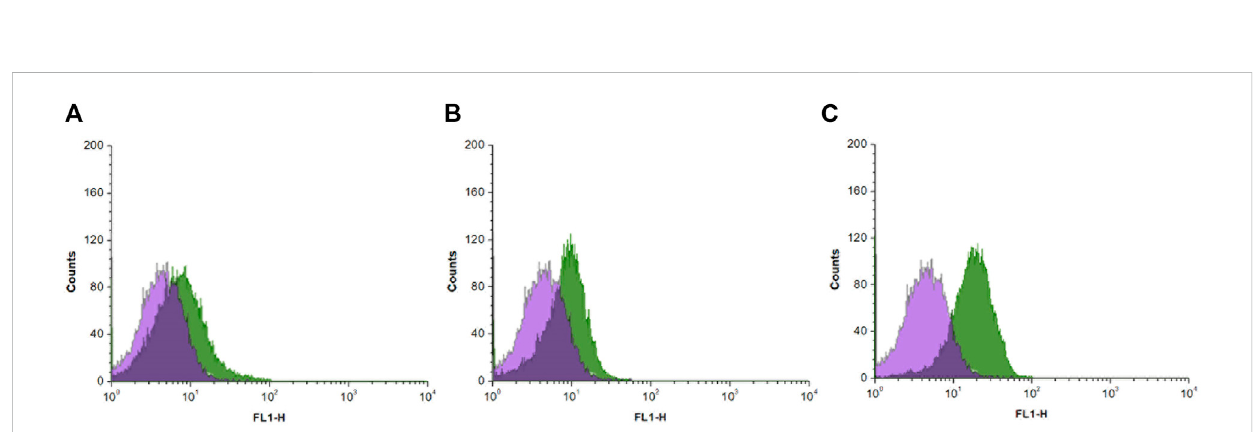
FIGURE 4 Histograms of fl ow cytometry analysis results of canine adipose-derived mesenchymal stem cells treated with (A) FP1 (B) FP2, and (C) FP3, showing the fl uorescence intensity of the probes in cells.